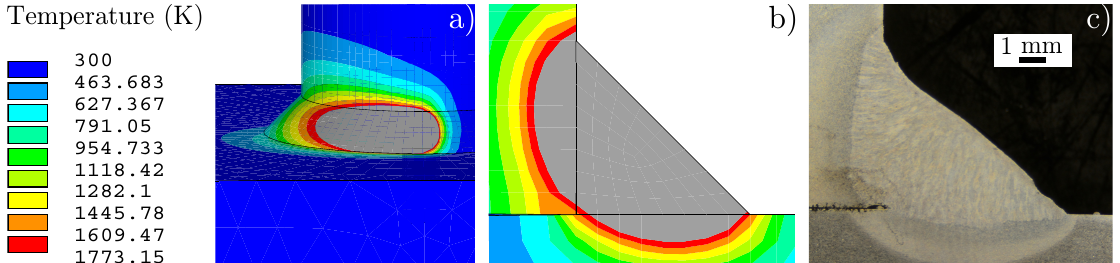
Figure 7. Goldak’s double-ellipsoid model: Overview of the thermal solution ( a ), finite-element (FE)-model cross section of the weld seam ( b ), real cross section of the weld seam ( c